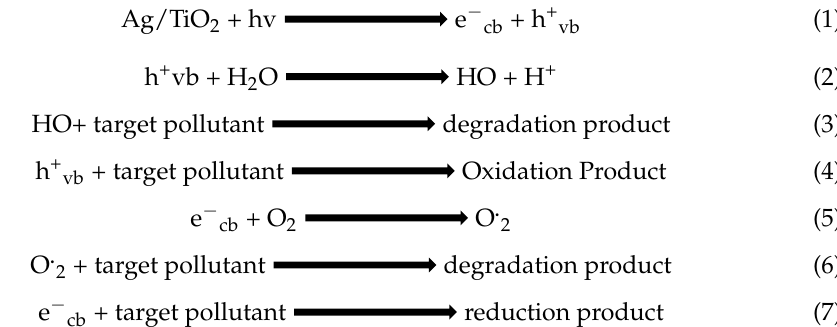
Figure 11. ( a ) The pseudo first order kinetics of 0.01Ag/TiO 2 composite. ( b ) The pseudo first-order kinetics of 0.1 Ag/TiO 2 composite. ( c ) The pseudo first-order kinetics of 0.5 Ag/TiO 2 composite.